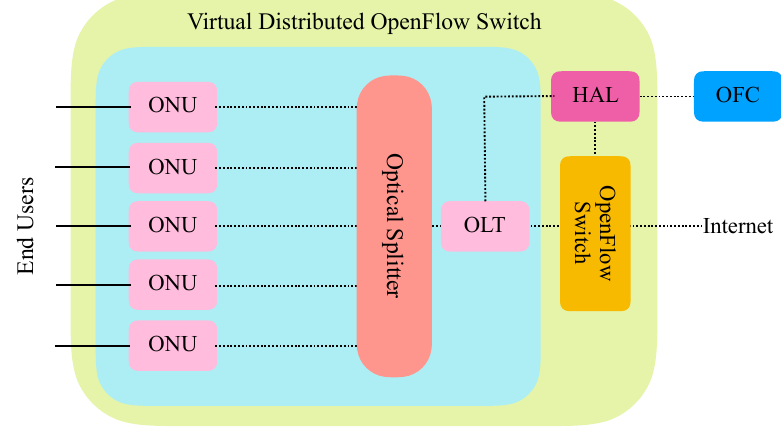
Figure 6. The architecture which allows the EPON to use